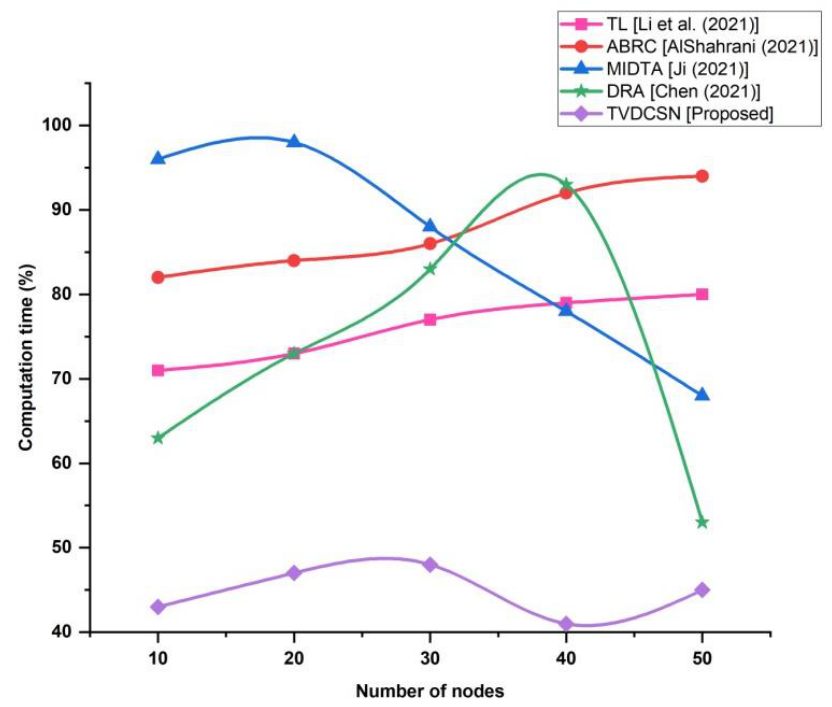
Figure 9. Proposed and existing methods of computation time. Figure 10. Proposed and existing methods of computation time . Table 5. Values of proposed and existing methods computation time.